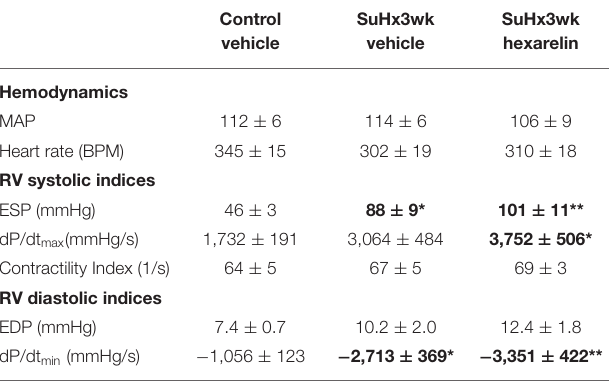
TABLE 2 | Right ventricular hemodynamic and function indices from study